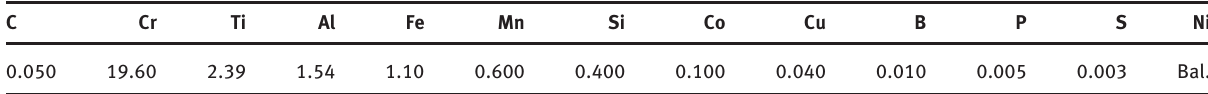
Table 1: Chemical composition of Nimonic 80A (wt%).